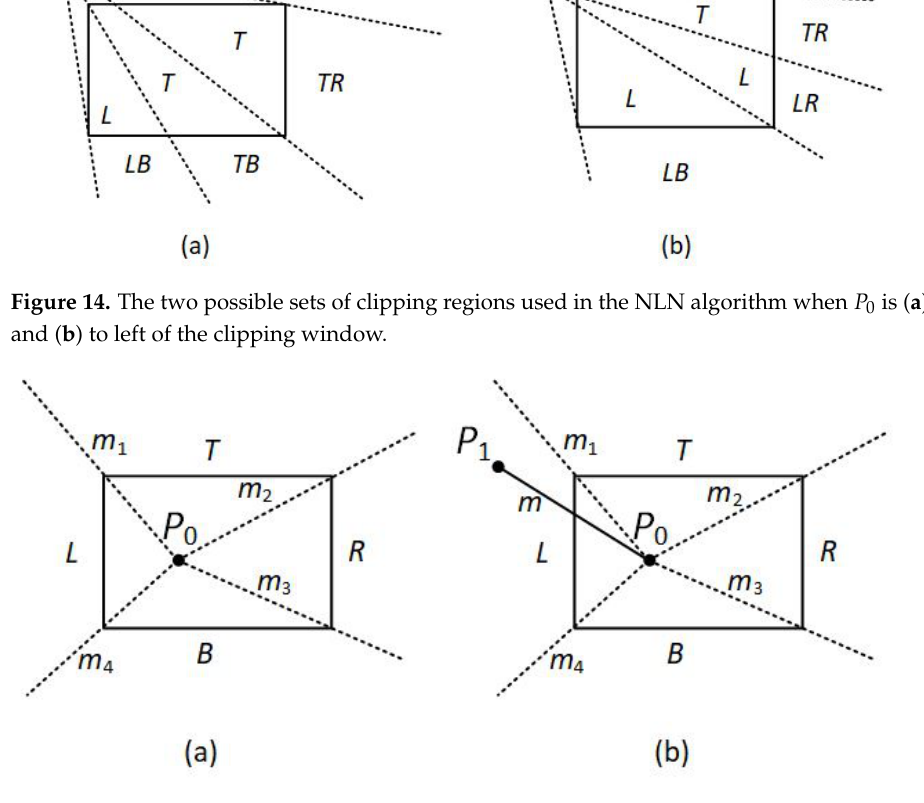
Figure 15. ( a ) m 1 , m 2 , m 3 , m 4 are the slopes of the line segments formed between P 0 and L, T, R, B, boundaries respectively. ( b ) m is the slope of the line segment P 0 P 1